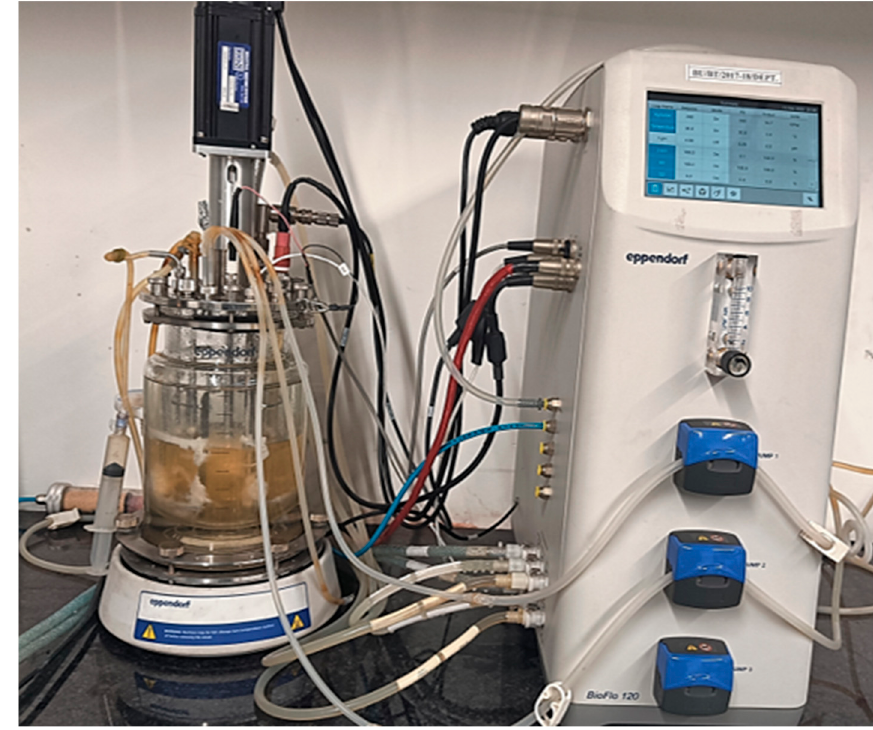
Figure 11. Picture of the bioreactor.